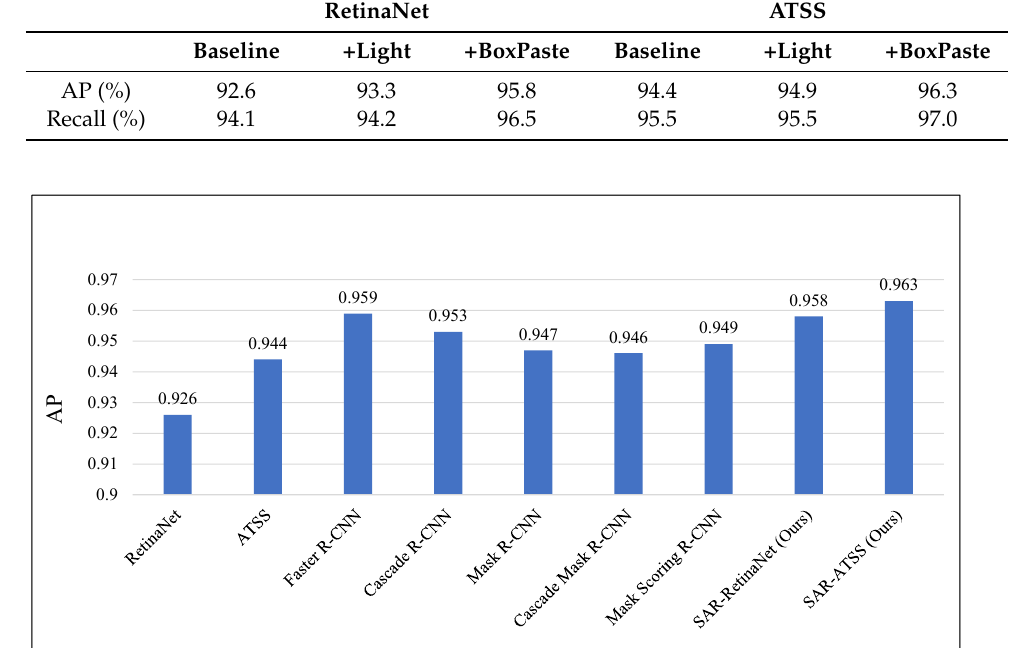
Figure 7. Combining the proposed methods on RetinaNet and ATSS and comparing them against current state-of-the-art